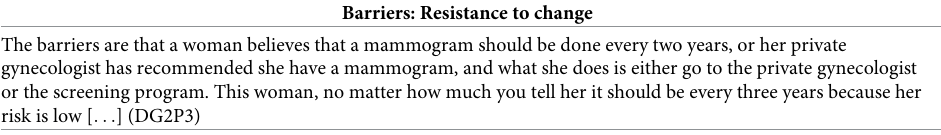
Table 2. Selected quotes from health professionals’ discussion groups on barriers and facilitators for women regarding participation in risk-based screening. Barriers: Resistance to